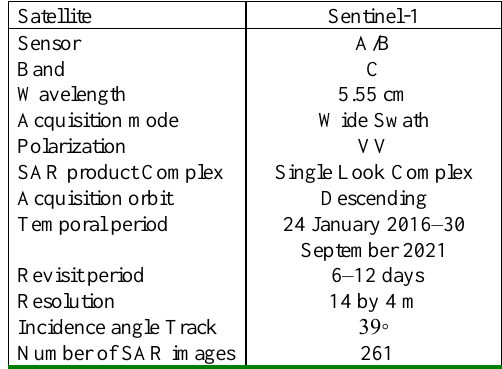
Table 1. Main acquisition parameters of the SAR satellite dataset